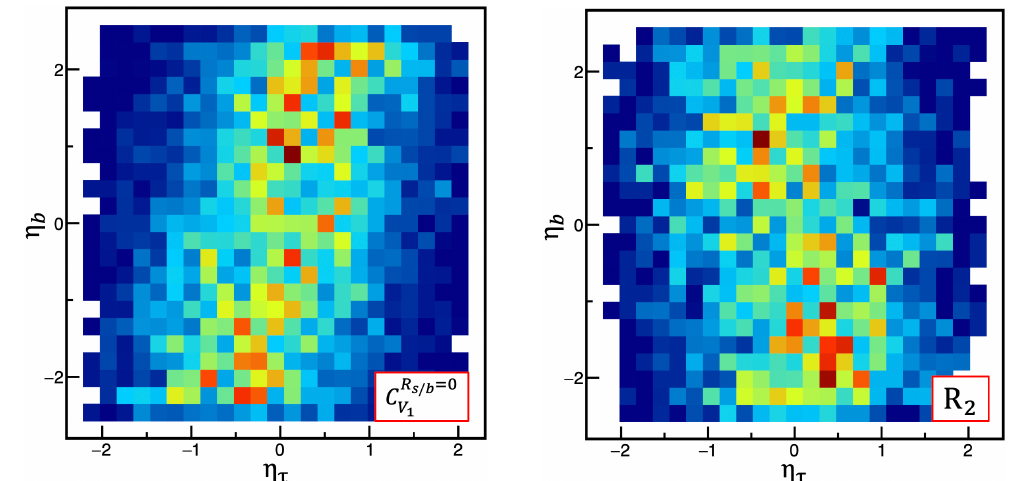
Figure 7 . Distribution of signal number density in η τ – η b plane for the single-U 1 ( C R s/b =0 single-R 2 ( C S ) (right). In both scenarios, the LQ mass is set to be 1 . 5 TeV . The warmer/reddish 2 (colder/bluish) colors represent larger (smaller) number of signal